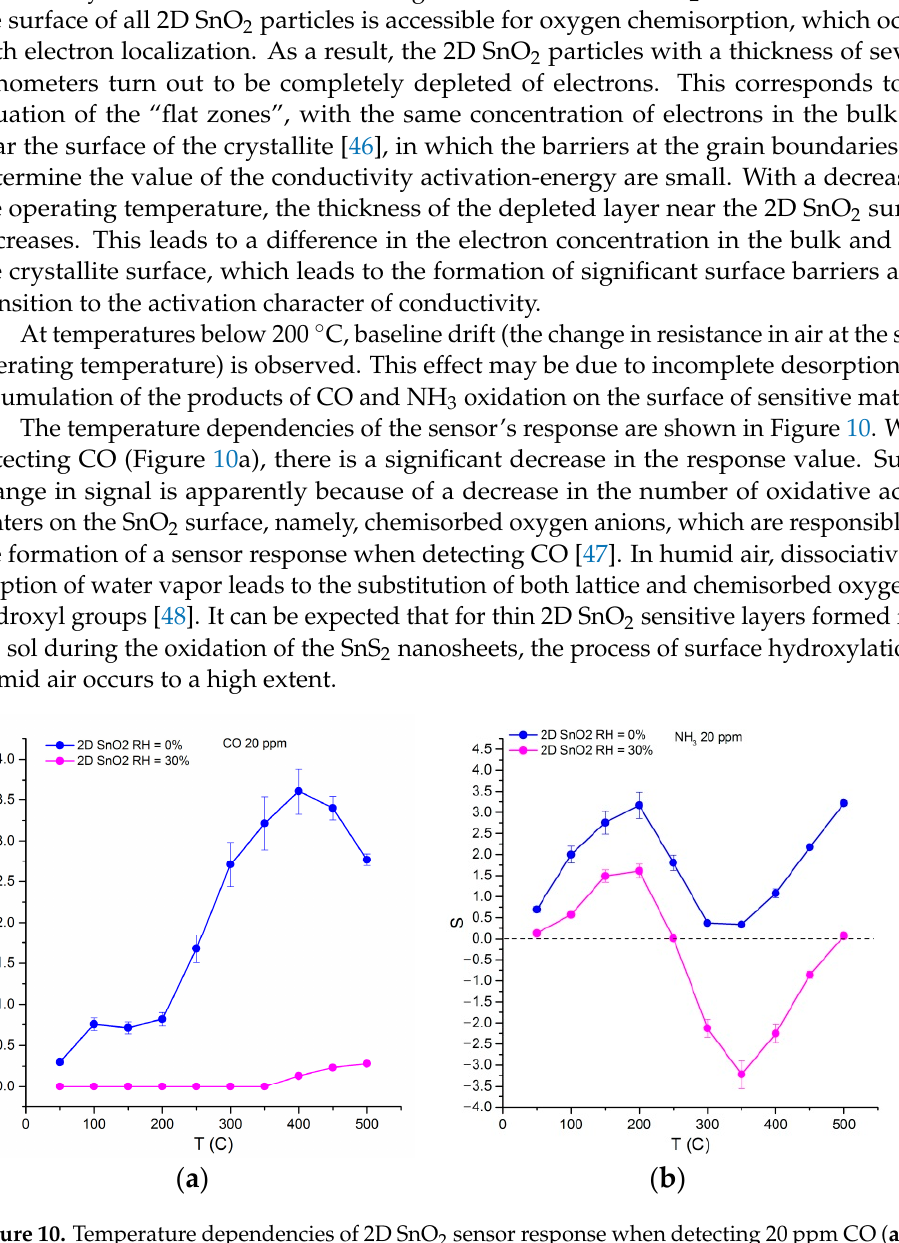
Figure 10. Temperature dependencies of 2D SnO 2 sensor response when detecting 20 ppm CO ( a ) and 20 ppm NH 3 ( b ) in dry (RH 25 = 0%) and humid (RH 25 = 30%) air.